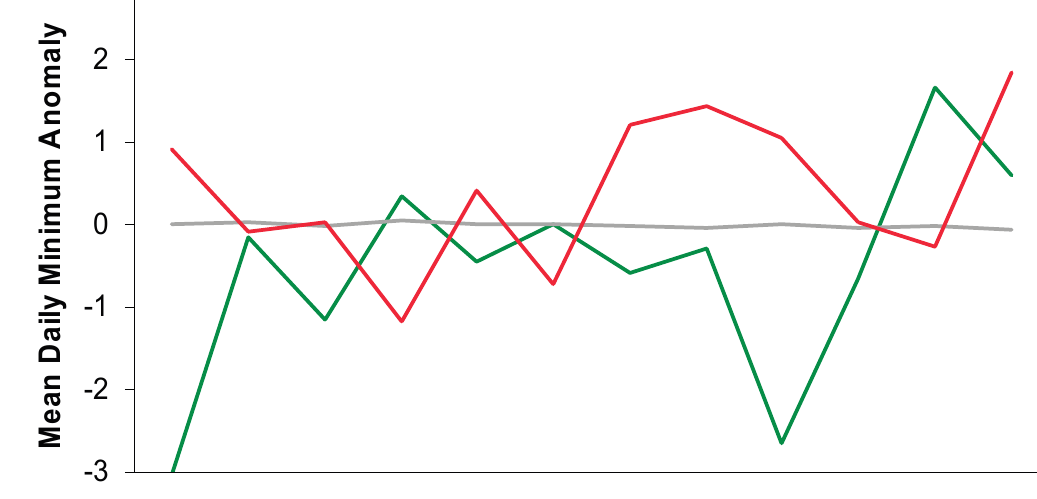
high-end (red), low-end (green), and all other (gray) suicide weeks in Toronto.